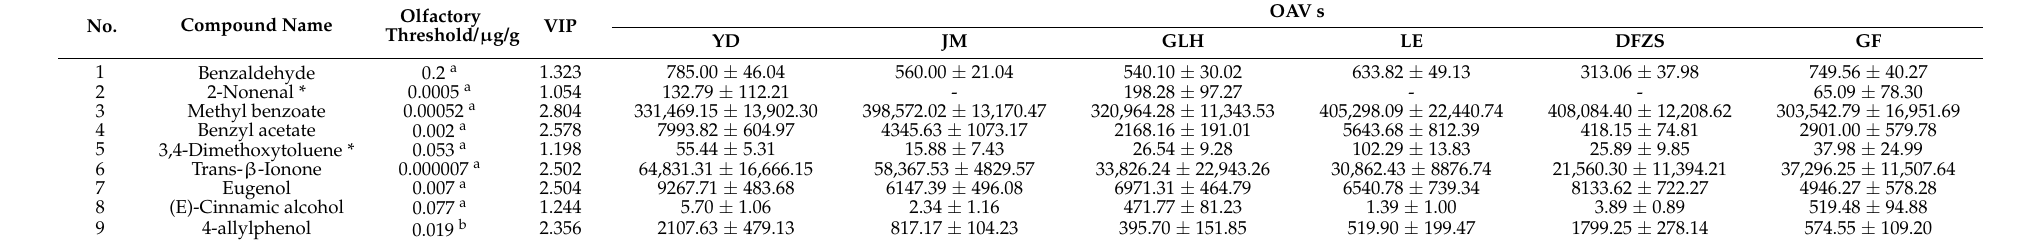
Table 3. Aroma description of nine volatile metabolites VIP > 1 based on their OAVs in six cultivars of P. mume